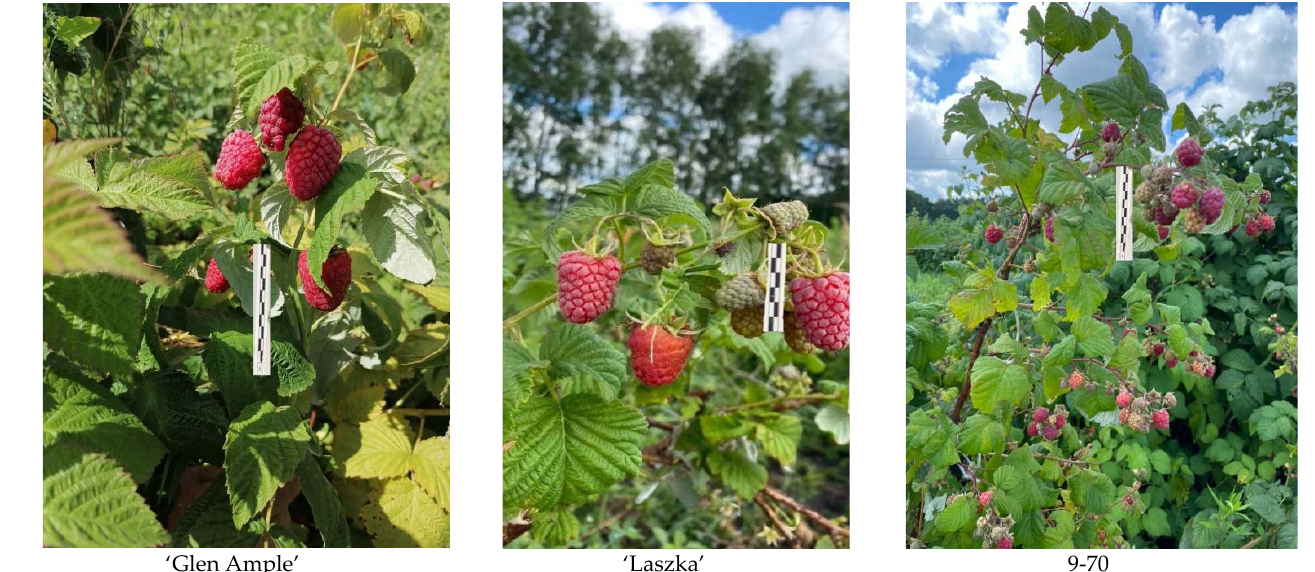
Figure 8. Promising raspberry genotypes.